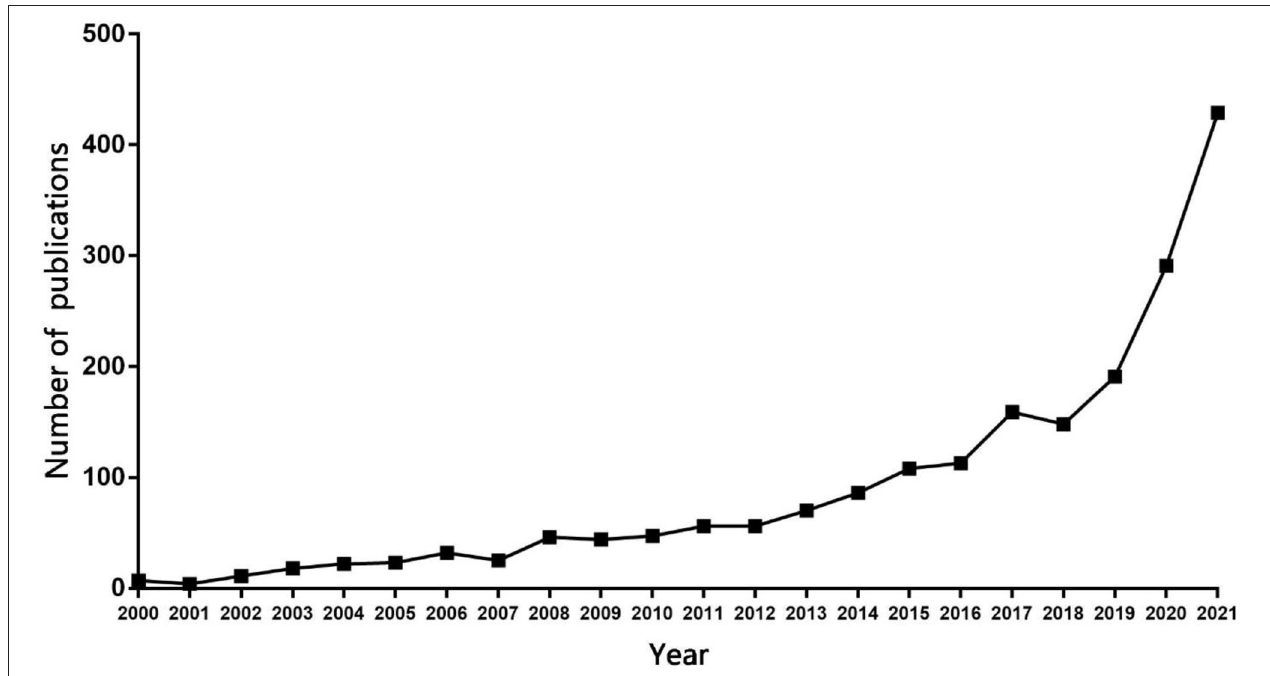
FIGURE 1 | Annual number of published articles from 2000 to 2021.